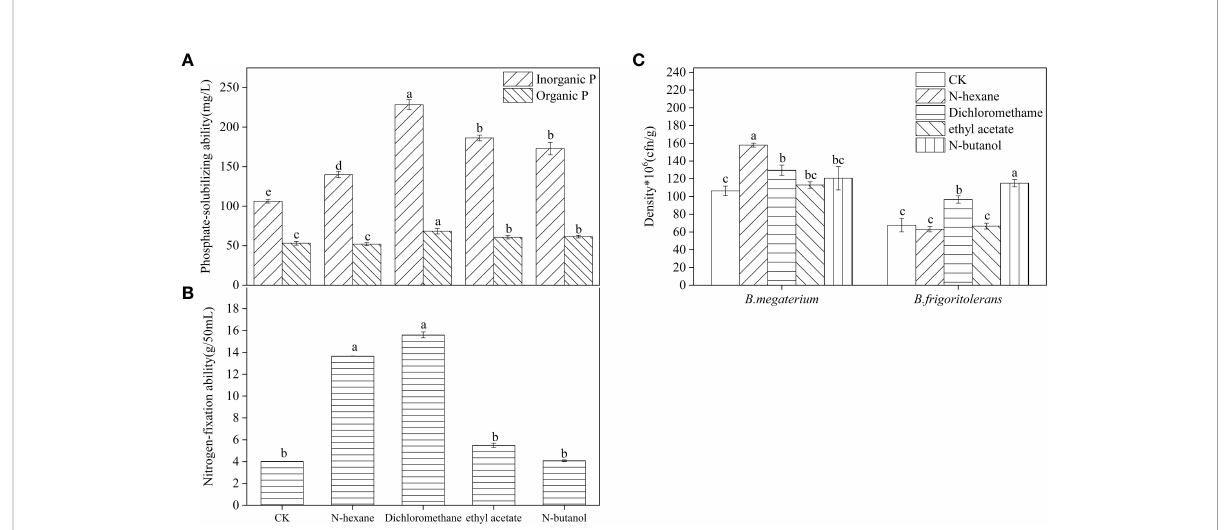
FIGURE 4 The effect of different extraction phases of root exudates on the phosphate-solubilizing ability of B . frigoritolerans (A) and the nitrogen- fi xation of B . megaterium (B) and their densities (C) . Different lowercase letters above the data bar indicate that the strain with different extracts treatments has signi fi cant differences at the P < 0.05 level. The “ * ” indicated that density of the Bacillus strains multiplied by 10 6